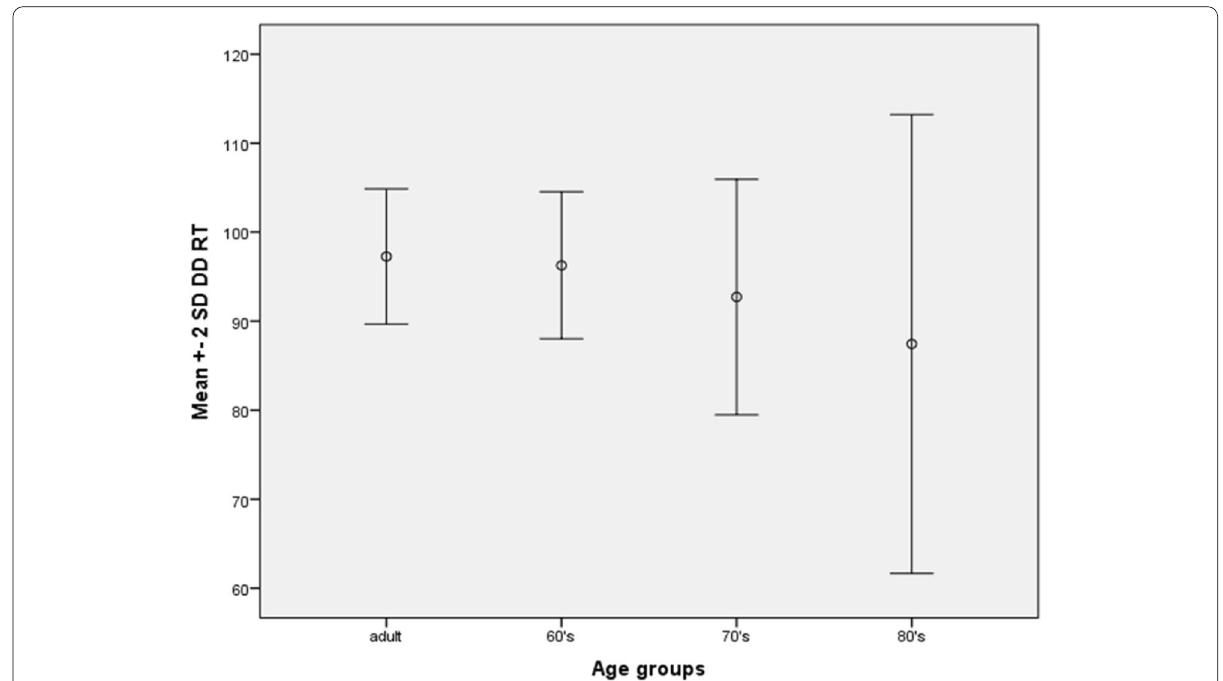
Fig. 1 Mean and SD of scores of DD test in the right ear in the adult group and elderly subgroups